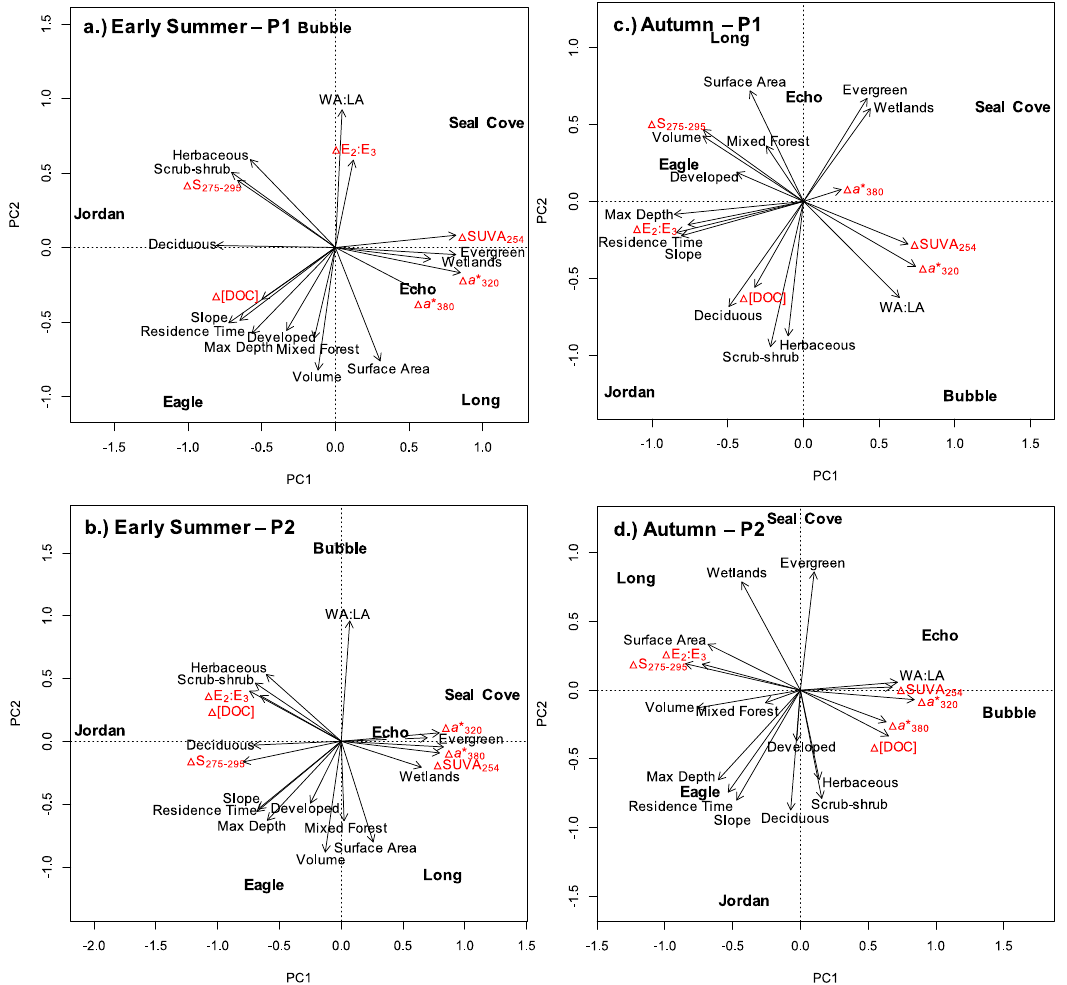
Figure 6. PCA plot illustrating changes between the percent change of [DOC], SUVA 254 , a * 320 , a * 380 , E 2 : E 3 , and S 275–295 and environmental variables (lake characteristics land cover) during the Early Summer for ( a ) P1 and ( b ) P2 and Autumn ( c ) P1 and ( d ) P2 storm samplings. DOC metrics are indicated by red font, environmental variables are in black font.